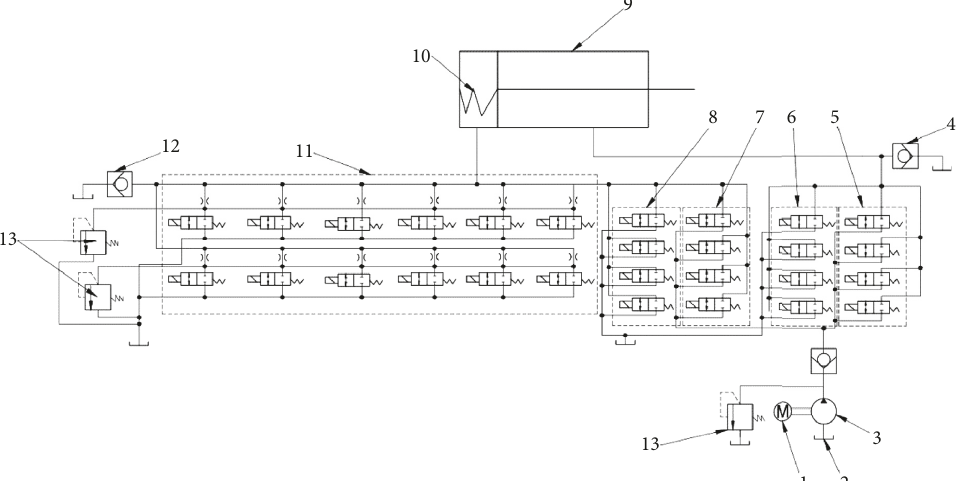
Figure 1: Digital buffer hydraulic system. (1) Motor; (2) tank; (3) gear pump; (4) check valve for rod chamber; (5) group of oil inlet control valves for rod chamber; (6) group of oil outlet control valves for the rod chamber; (7) group of oil inlet control valves for the rodless chamber; (8) group of oil outlet control valves for the rodless chamber; (9) cylinder; (10) reset spring; (11) digital throttle unit; (12) check valve for the rodless chamber; (13) safety